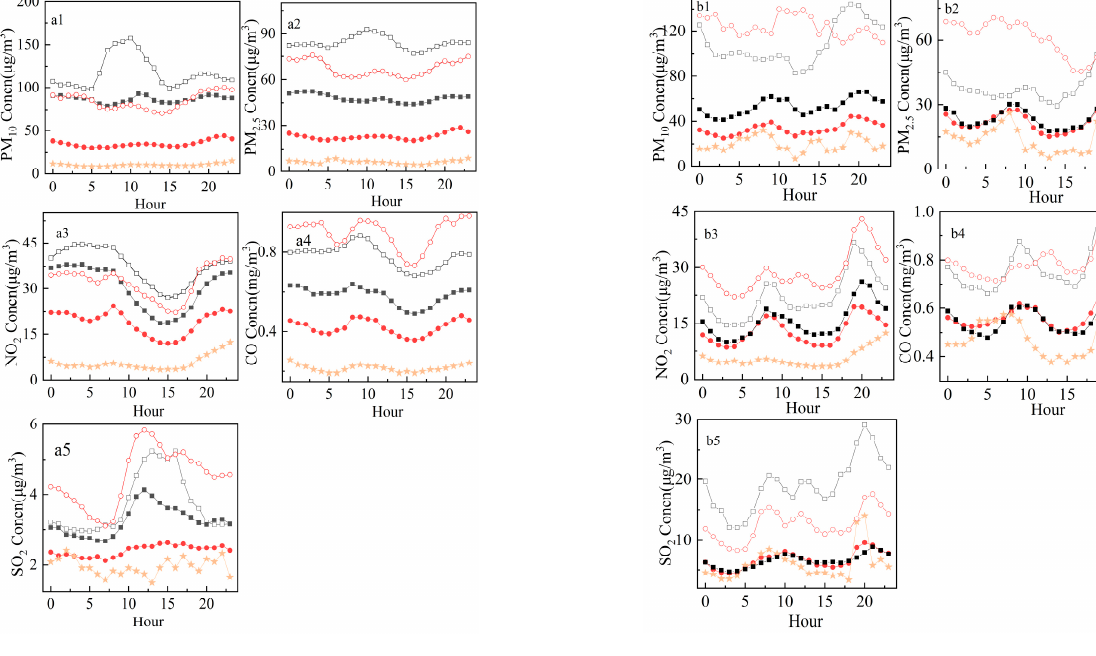
Figure 4. Average pollutant concentrations in ( a ) Beijing and ( b ) Zhangjiakou at different times. ( a1 – a5 ) show the PM 10 , PM 2.5 , NO 2, CO, and SO 2 concentration in Beijing respectively, ( b1 – b5 ) show the PM 10 , PM 2.5 , NO 2, CO, and SO 2 concentration in Zhangjiakou respectively.